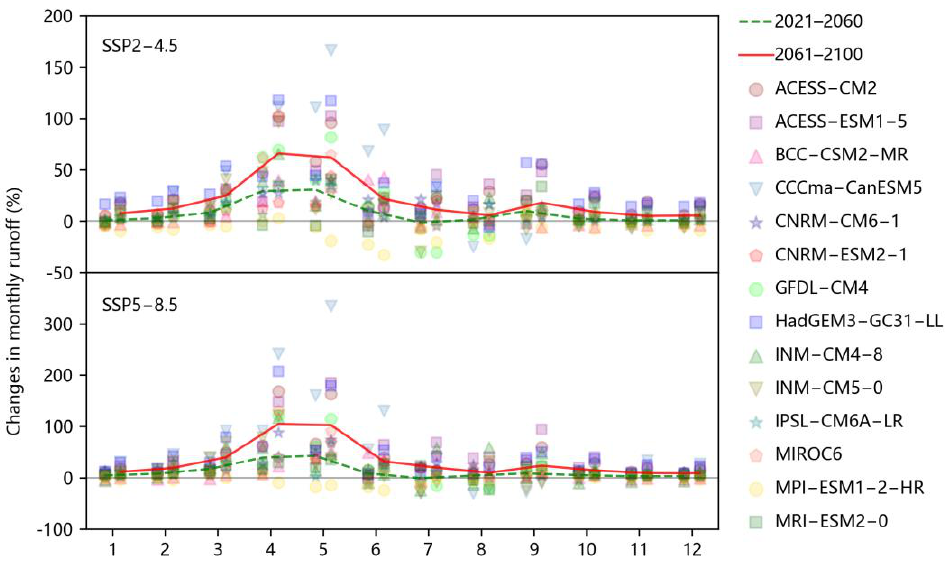
Figure 6. Simulated monthly runoff changes in the Fujian River basin for 2021–2060 and 2061–2100 under 14 GCMs and 2 SSP-RCPs (relative to 1971 – 2010).